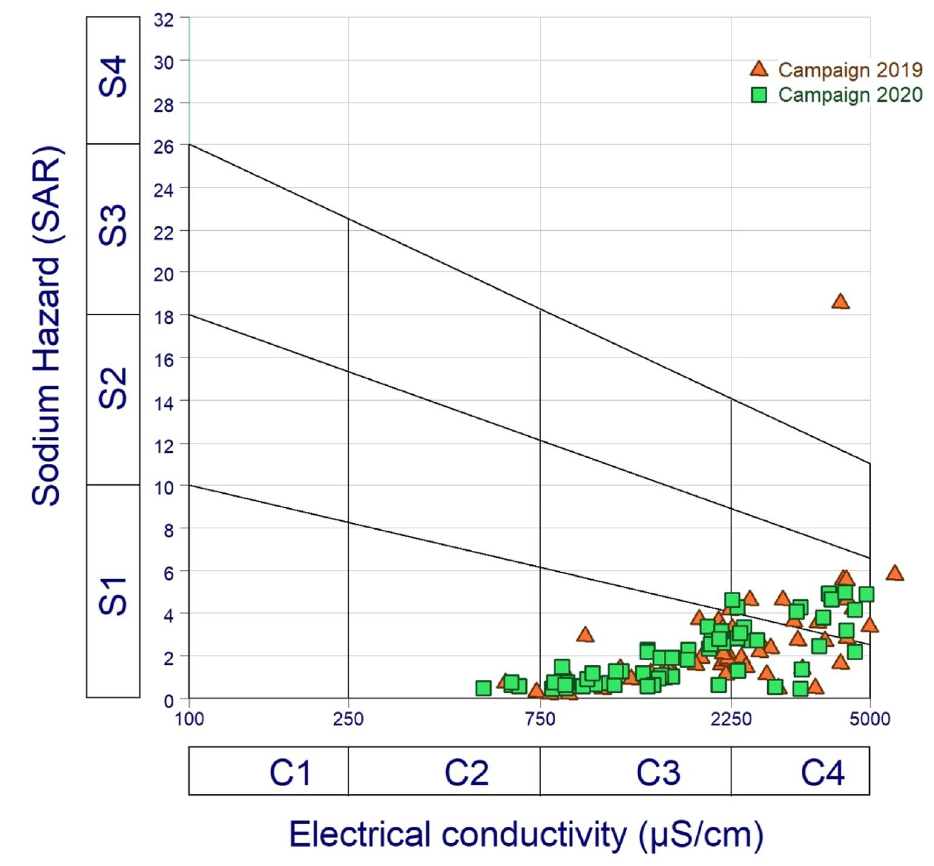
Fig. 4 Irrigation water classifi- cation diagram United States Salinity Laboratory